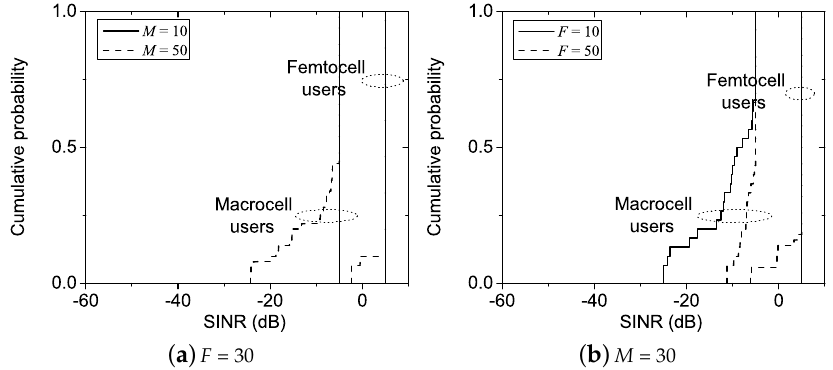
Figure 7. Probability distribution of users’ achieved SINRs under various numbers of macrocell and femtocell users when the per-user handover control is considered (the target SINR of macrocell users and that of femtocell users are − 5 dB and 5 dB, respectively).